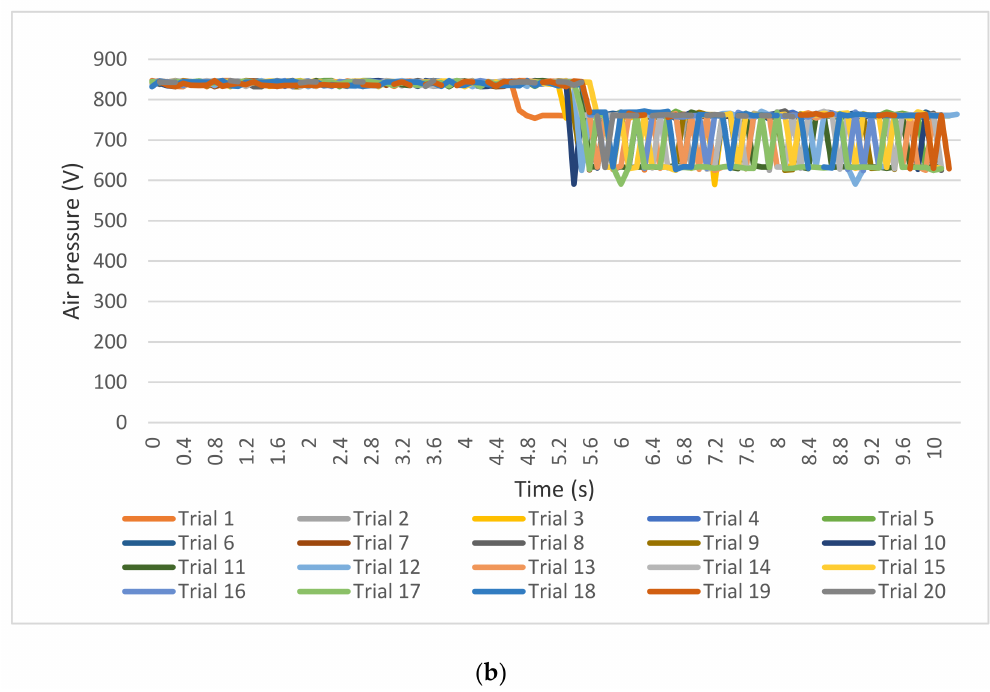
Figure 6. Measured air pressure over time: ( a ) successful lift for box type I; ( b ) failed lift for box type II.